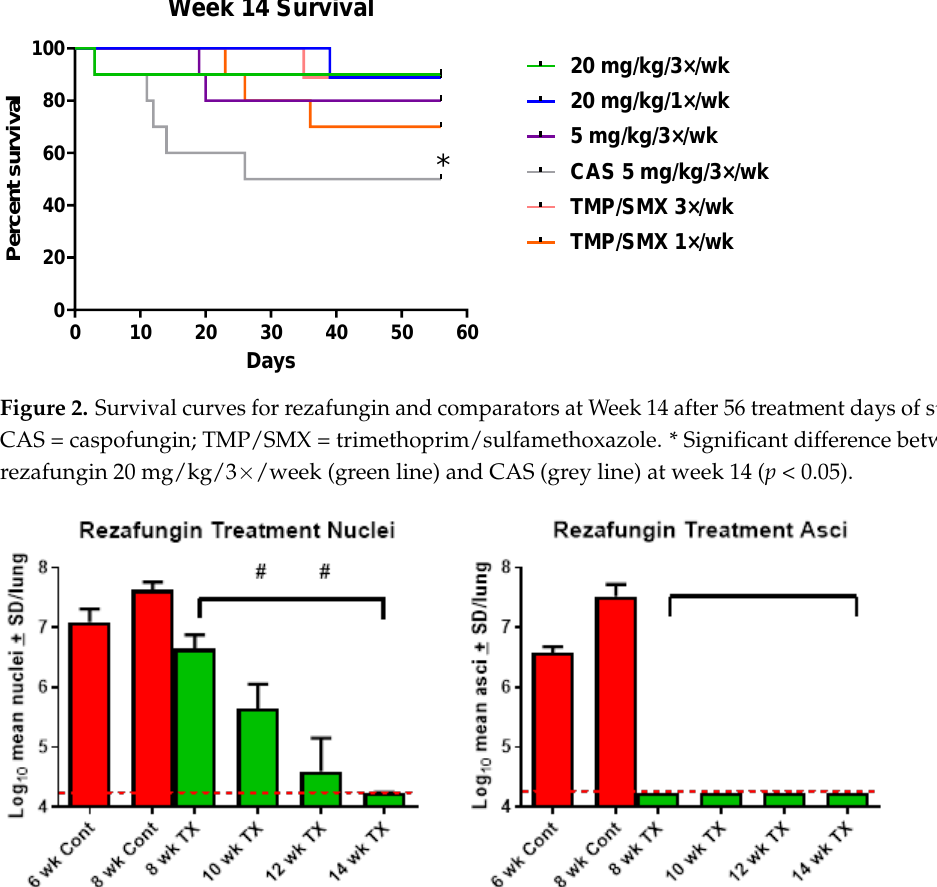
Figure 3. Treatment with rezafungin eliminates P. murina . Log 10 mean nuclei and asci counts after 2 to 8 weeks of rezafungin treatment. Color code: red = vehicle treated control bars; green = rezafungin-treated 20 mg/kg/3×/week. Bracket denotes significant difference from 8-week control ( p < 0.05). # denotes significant difference from previous week timepoint. Red dotted line indicates limit of detection (log 10 4.24).